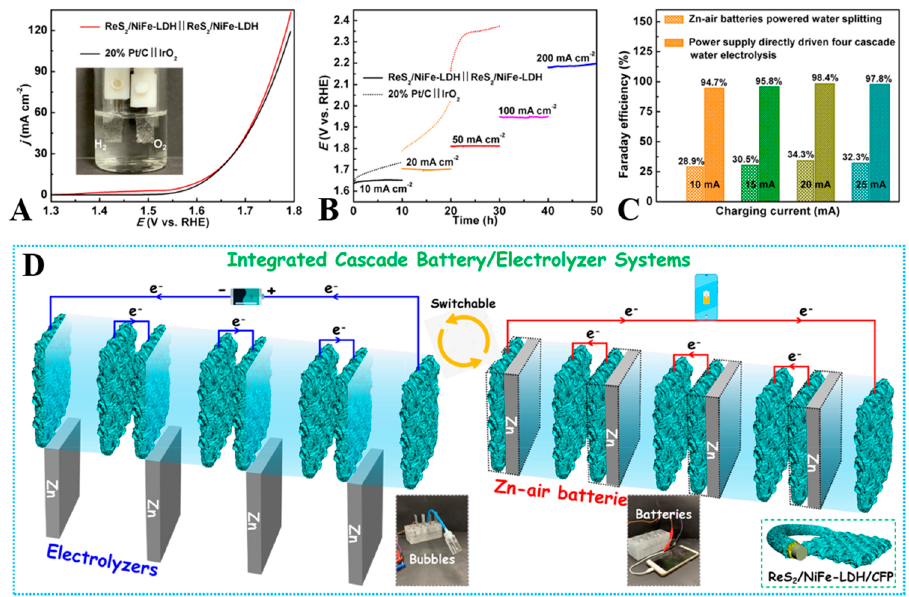
Figure 17. ( A ) Overall water electrolysis LSV curves of the ReS 2 /NiFe-LDH ‖ ReS 2 /NiFe-LDHs and 20% Pt/C ‖ IrO 2 in 1 M KOH solution. Insets show the digital photograph of the two-electrode configuration. ( B ) Chronopotentiometry curves at various current densities. ( C ) Faraday e ffi ciencies of the Zn − air ba tt eries-powered water electrolysis and the power supply directly driven four-cascade water electrolysis at different charging current. ( D ) Schematic illustration and digital photo- graphs of the integrated cascade battery/electrolyzer systems for electrolyzer (H 2 production) and batteries (mobile charg- ing) operations [241]. Copyright © 2021 American Chemical Society. Table 2. The bifunctional performances of LDHs-based materials in alkaline medium.